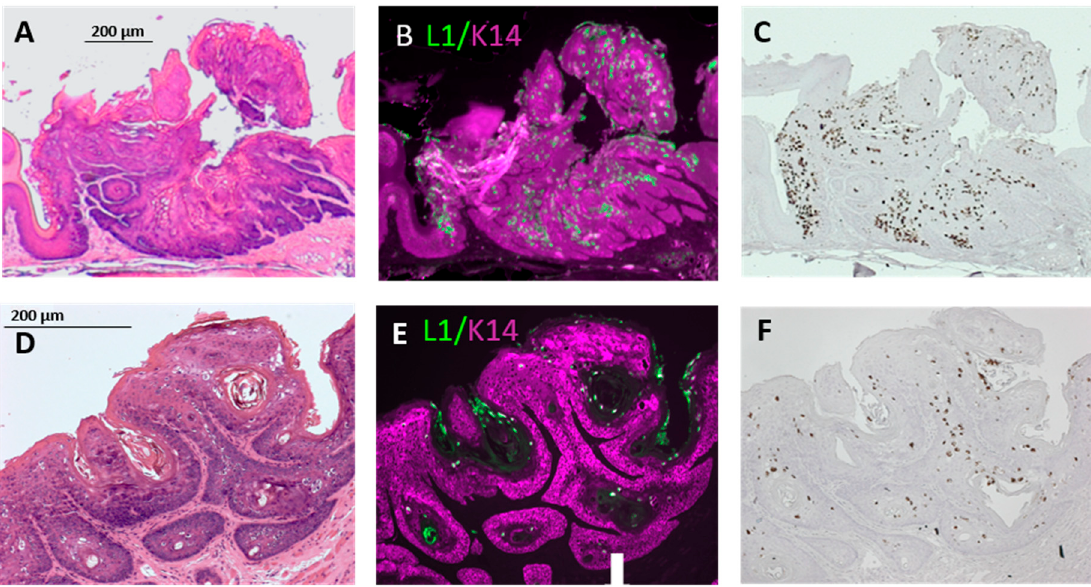
Figure 3. Soft palate tumors express viral capsid protein. ( A ) The soft palate tumor in Figure 2A, stained with hematoxylin and eosin (H&E). ( B , C ) The tumor in ( A ) after ( B ) immunohistochemical (IHC) detection of L1 capsid protein (green: “L1”) and Keratin 14 (magenta; “K14”) and ( C ) in situ hybridization with probes for MmuPV1 E6 and E7. ( D ) The tumor in Figure 2B stained with H&E. ( E , F ) The tumor in ( D ) after ( E ) L1 and K14 IHC and ( F ) in situ hybridization with probes for MmuPV1 E6 and E7.